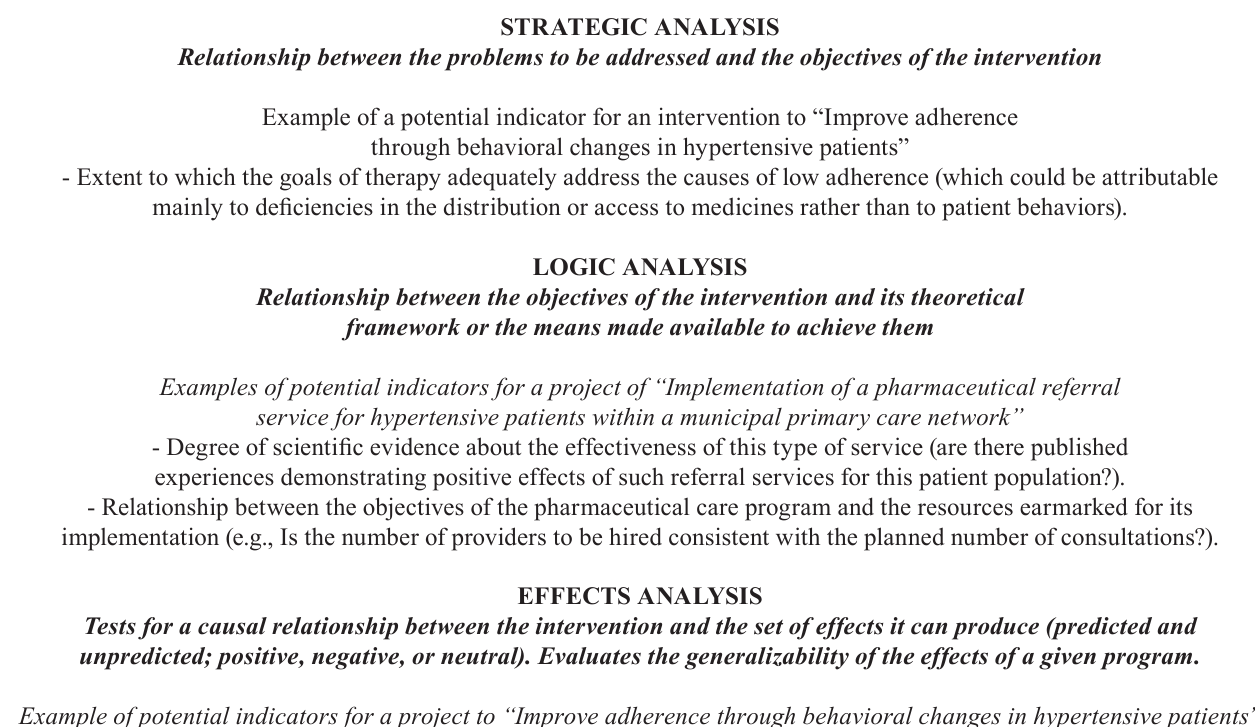
TABLE I - P ossible indicators for normative assessment and evaluative research of pharmaceutical care interventions in the selected problem